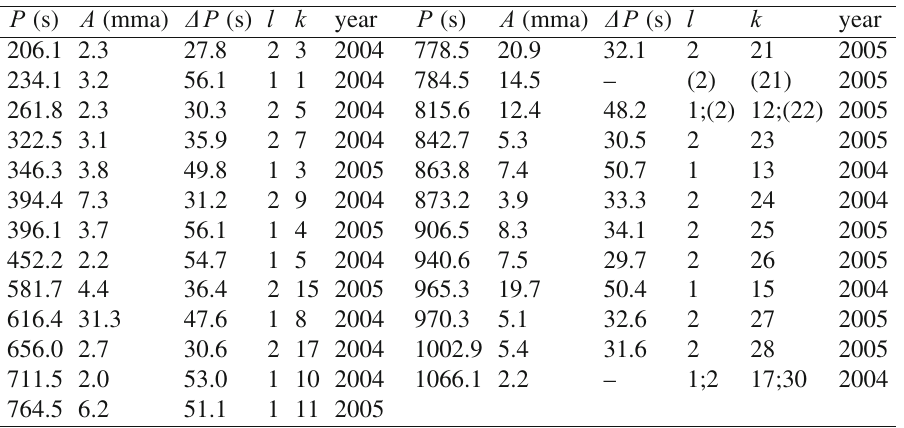
Table 1. List of 25 identified modes of PG